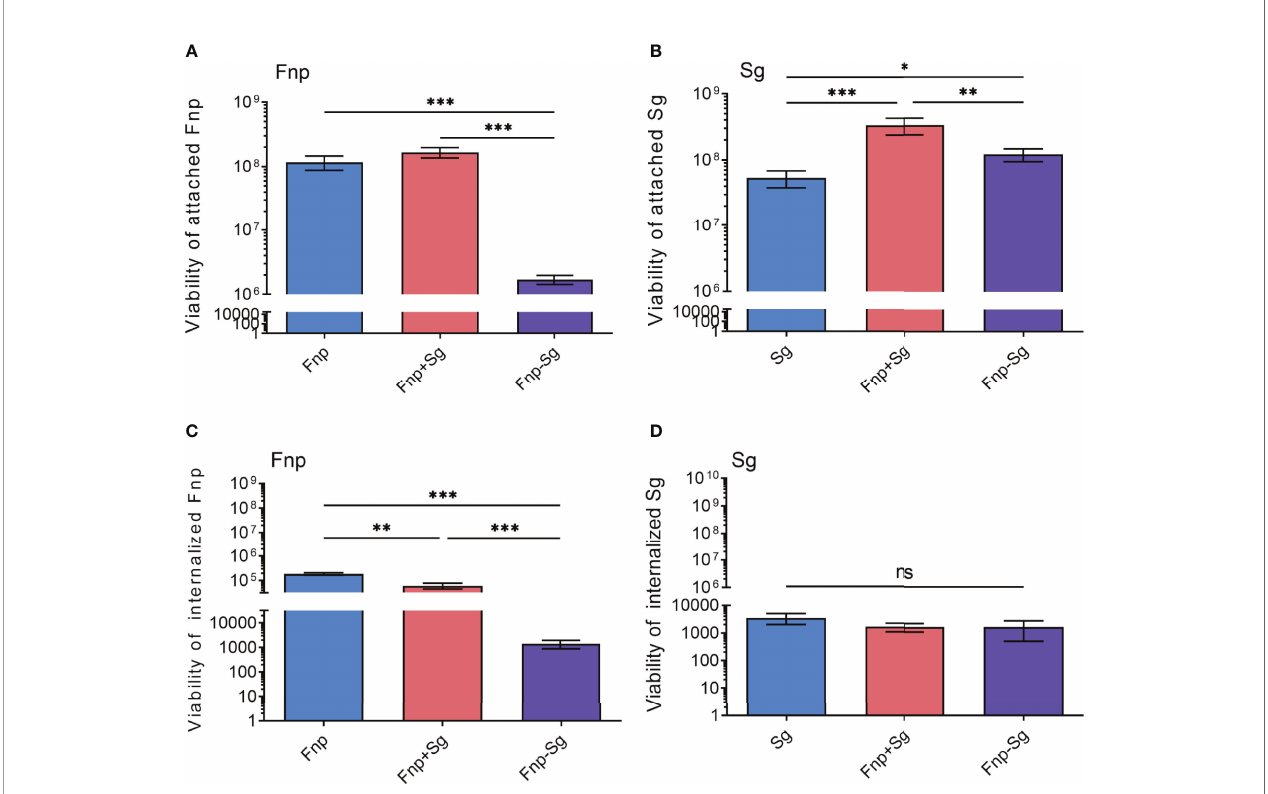
FIGURE 4 | The numbers of attached F . nucleatum subsp. polymorphum (A) and S. gordonii (B) , internalized F . nucleatum subsp. polymorphum (C) and S. gordonii (D) to hGECs with an MOI of 100 after 4 h of infection (* p <0.05 , ** p <0.01 , *** p <0.001 , ns: not statistically signi fi